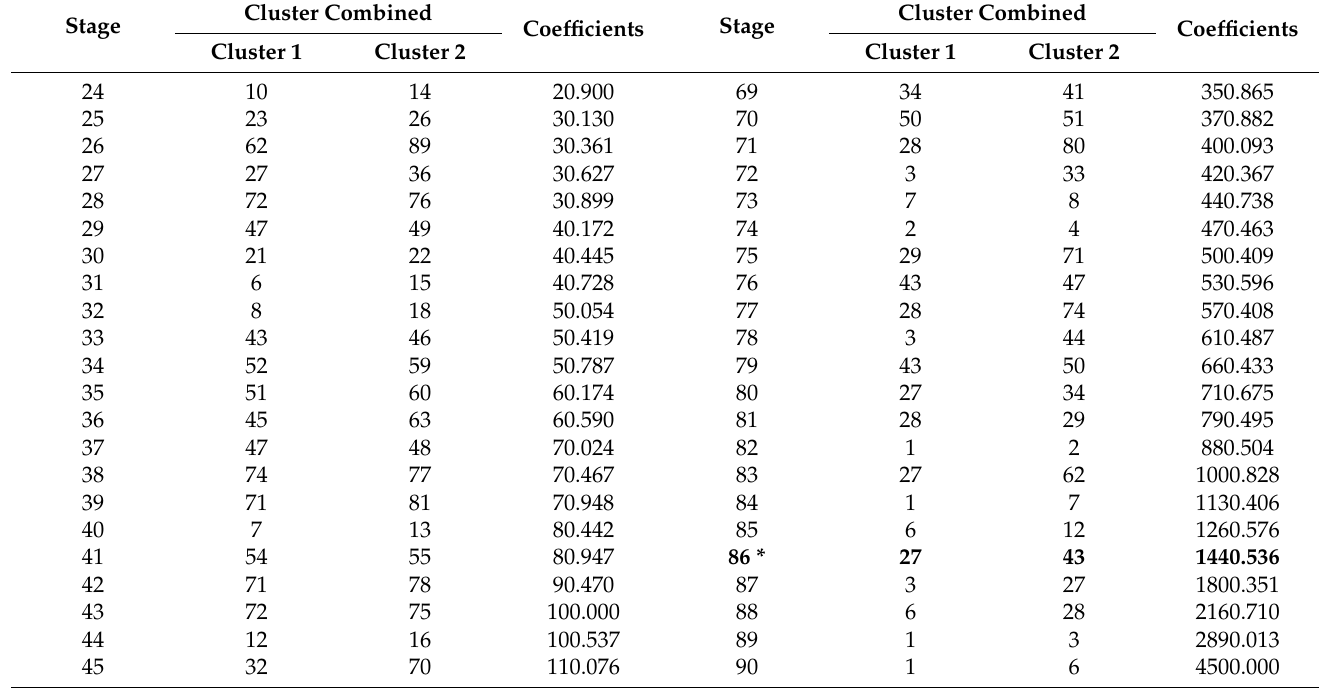
Figure A2. Dendrogram. The red line indicates the cut-off point (with 5 clusters, stage 86). Once the number of clusters is set, the classification is repeated with the k-means method. Results are very similar in both procedures; only six zones change to another cluster (6.5% of the cases). Therefore, the solution is considered stable (<10% cases to a different cluster) [62]. The classification obtained through k-means is preferred: it changes the cases (zones) from one cluster to another to obtain the best solution. Hierarchical meth- ods are very useful to establish the optimum number of clusters, but once the cases have